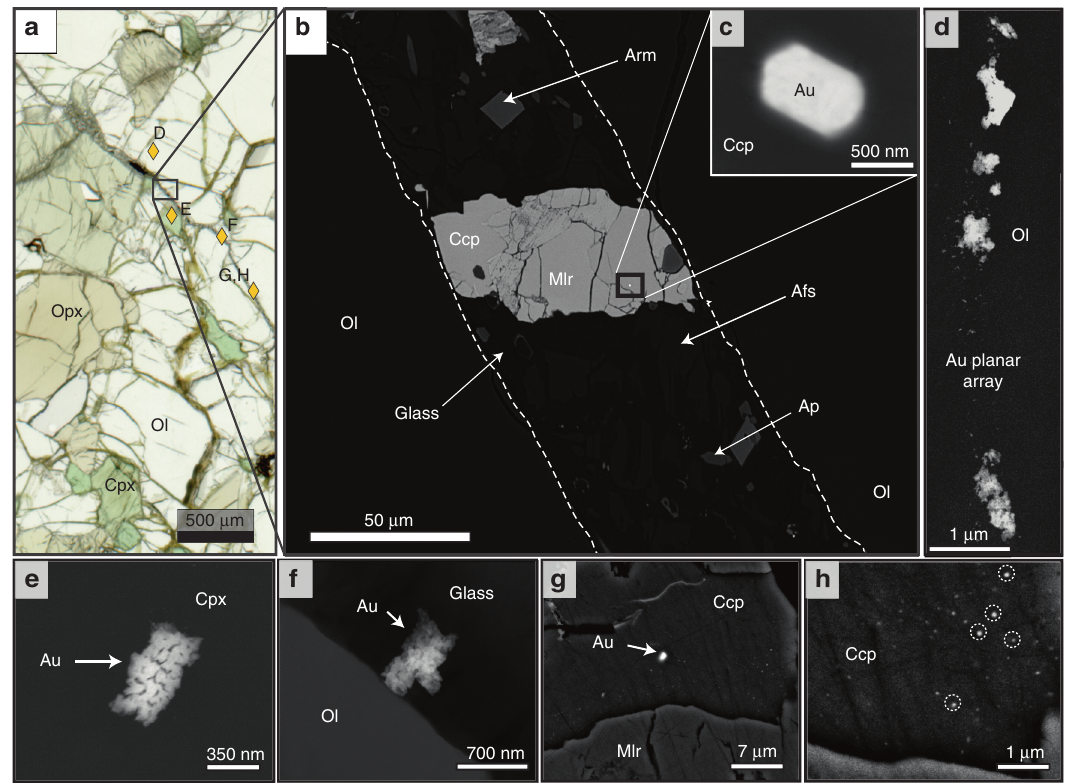
Fig. 2 Photomicrograph and backscattered electron (BSE) images of Au particles in the Cerro Redondo mantle xenolith. a Plane polarised light image of the lherzolite sample showing the late metasomatic glass vein and the location of Au particles ( golden diamonds and letters refer to BSE images). b – h Backscattered electron FE-SEM images of Au particles and their microstructural setting. b Detail of the glass vein showing its metasomatic assemblage and a composite sul fi de grain containing a Au particle. c Magni fi cation of the euhedral Au particle within chalcopyrite from the composite sul fi de grain in b . d Planar array of Au particles within olivine. e Au particle enclosed within clinopyroxene. f Au particle within the glass of the metasomatic vein in contact with olivine. g Au particle within chalcopyrite and arrangement of Au nanoparticles enlarged in h . Afs, alkali feldspar; Ap, apatite; Arm, armalcolite;